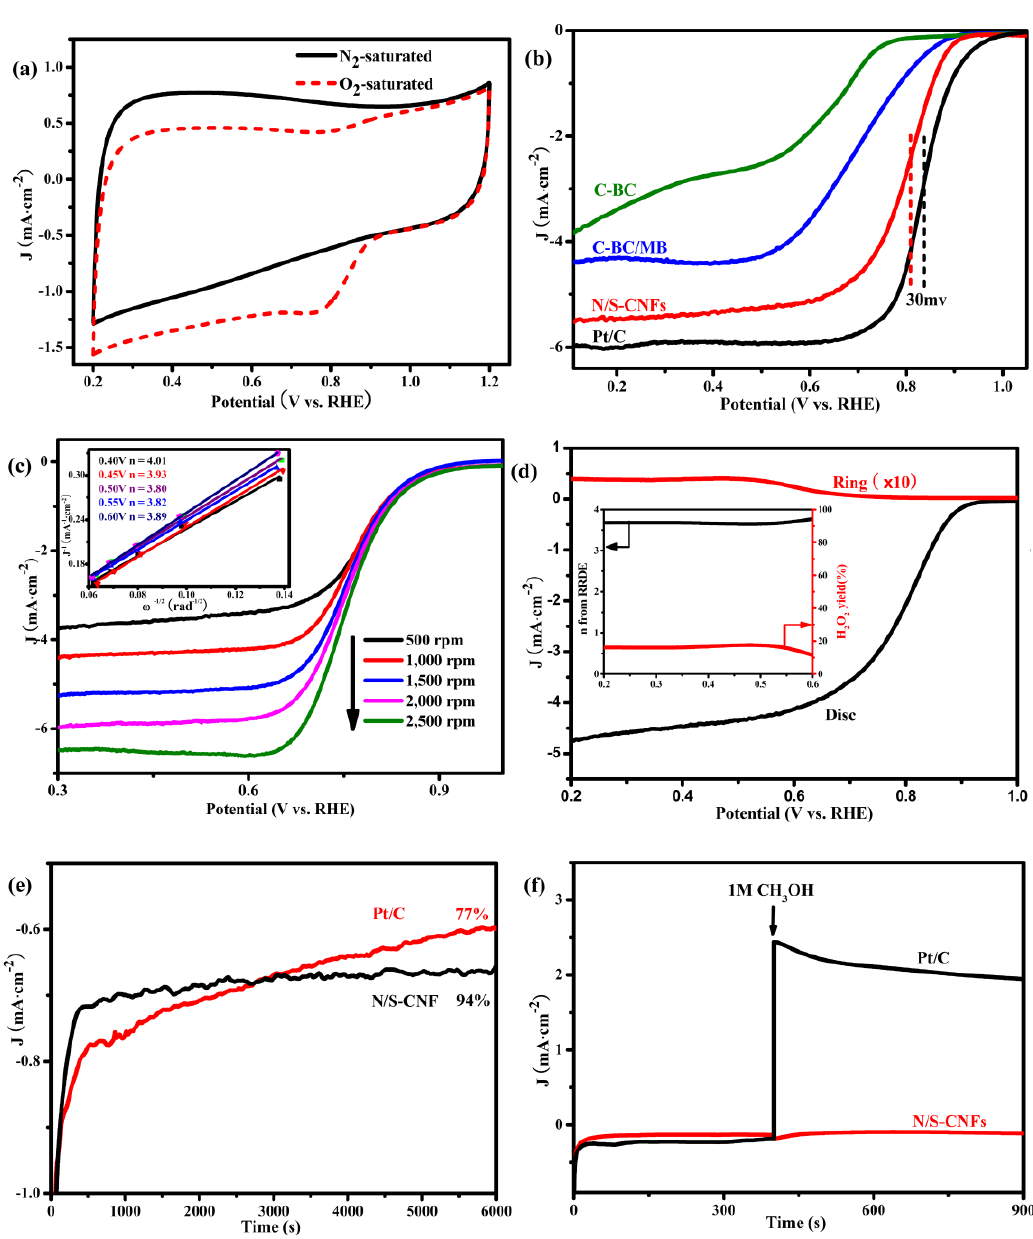
Figure 6. ( a ) CV curves of the N/S-CNF in N 2 /O 2 -saturated 0.1 M KOH solution at scan rate of 50 mV · s − 1 ; ( b ) ORR polarization curves of the C-BC, C-BC/MB, N/S-CNF and Pt/C electrocatalysts at scan rate of 10 mV · s − 1 and a rotation rate of 1600 rpm; ( c ) LSV curves of N/S-CNF at different rotation rates, and the inset is the corresponding Koutecky–Levich plots; ( d ) RRDE measurements for N/S-CNF electrode; chronoamperometry curves of the N/S-CNF and Pt/C obtained at 0.75 V for ( e ) the stability test; and ( f ) methanol tolerance test before and after adding 1 M methanol. ( b – f ) were obtained in O 2 -saturated 1 M KOH solution.